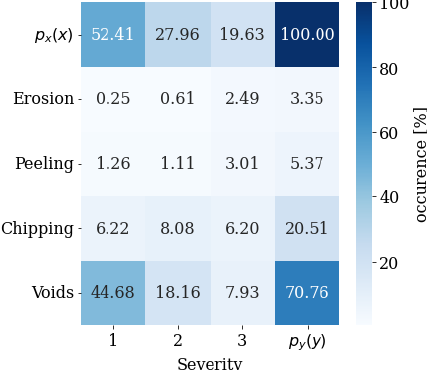
Figure 6. Marginal distribution of all observed defects after basic